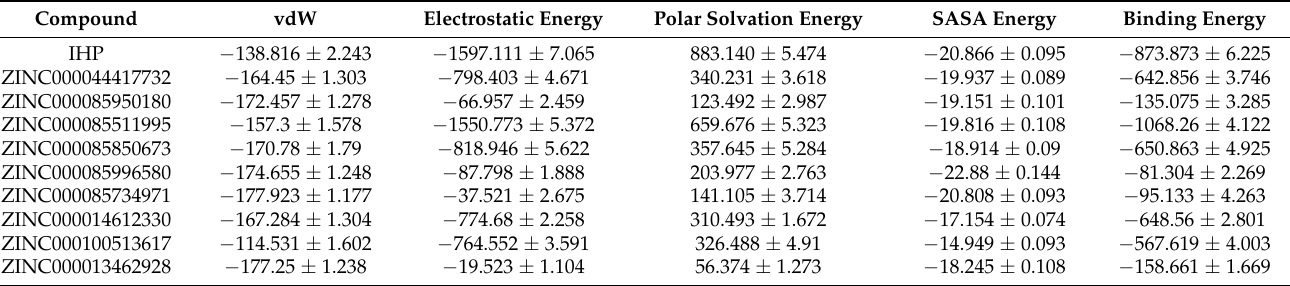
Figure 8. Chemical structures of IHP and the nine potential lead compounds. Table 4. Contributing energy terms for the protein–ligand complexes determined via MM/PBSA calculations. The energy values are presented as “energy ± standard deviation”. All energy values are in kJ/mol.